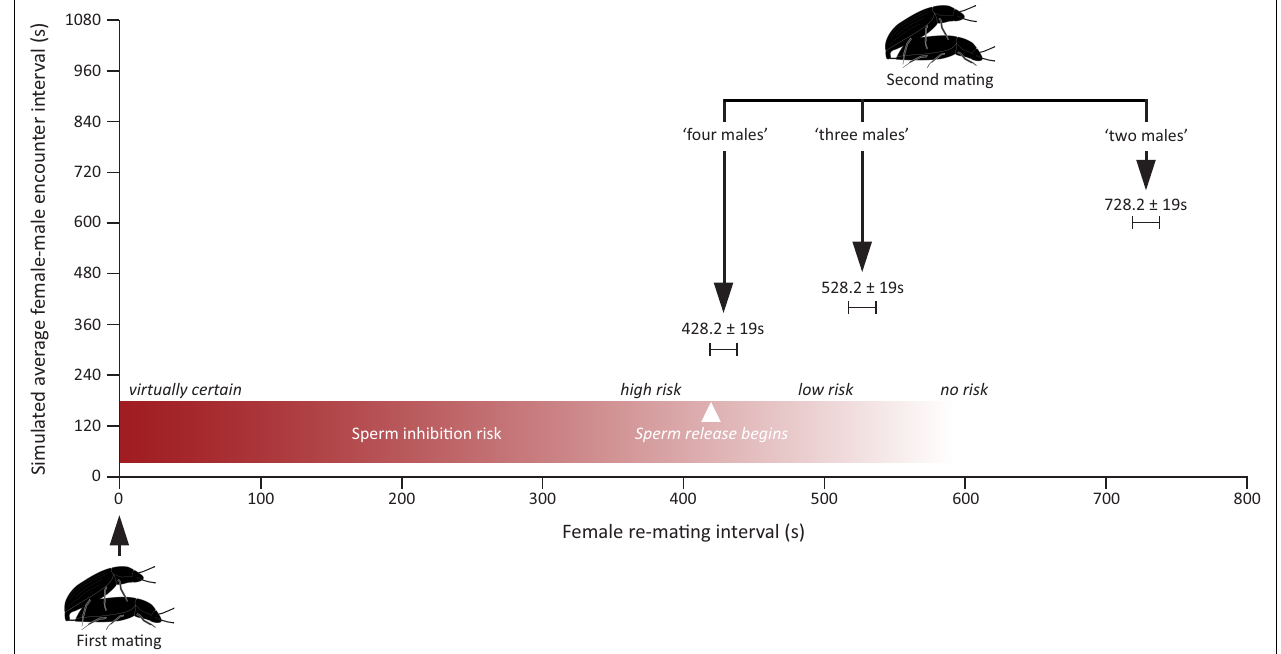
courtship and mate guarding duration were calculated from winsorized ( α = 0.05) data to prevent overestimation of both parameters due to the presence of outliers (see Materials and Methods).The risk of suffering from spermatophore inhibition is virtually one for re-mating intervals < 5min, high for re-mating intervals around 7min, and is then bound to drop fast for longer re-mating intervals as sperm release begins (Gadzama and Happ, 1974; Drnevich et al., 2000).This being so, the “four males” treatment is the only one simulating a situation in which males would face a significant increase in the risk of suffering spermatophore